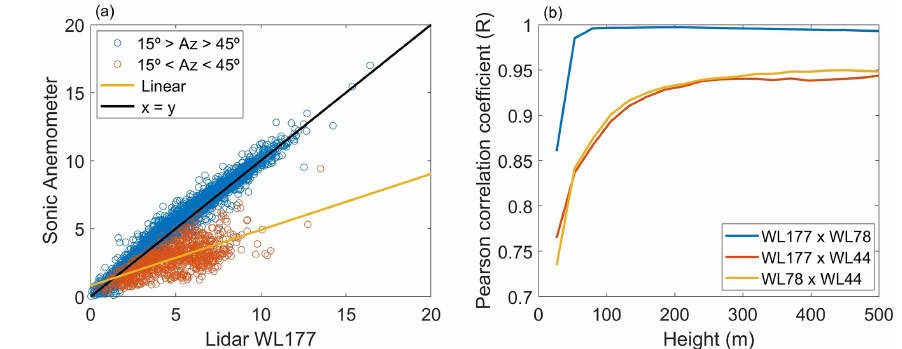
Figure 1. Data validation. (a) Comparison of the horizontal wind speed from the sonic anemometer against lidar WL177 at about 90ma.g.l. The comparison in the azimuth range between 15 and 45 ◦ is shown in red to highlight the effects of the tower shadowing effect. (b) Pearson correlation coefficient ( R ) of the different lidars against the height a.g.l. WL177 and WL78 are located in Falkenberg, while WL44 is operated ∼ 6km away in Lindenberg. Table 1. Location, operation mode, available number of days and periods with missing data of all instruments used to estimate the wind properties.